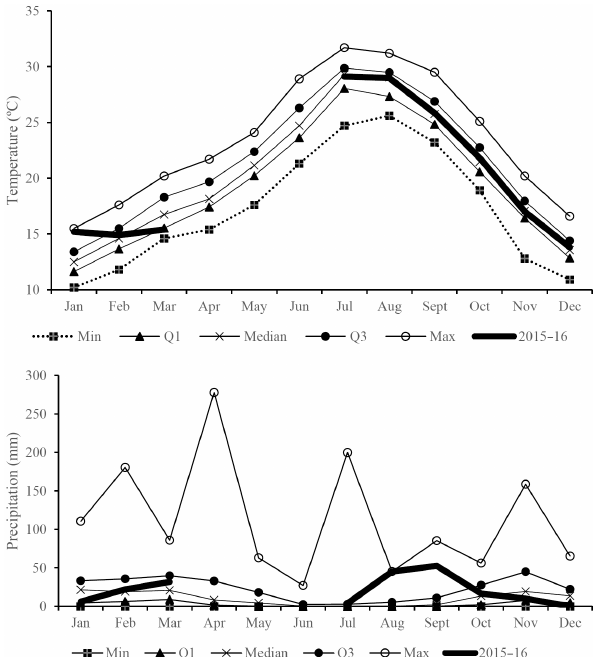
Figure 4. Statistics of mean annual monthly air temperature and precipitation at Menara (Marrakesh) from 1977 to 2015 and during the study period (July 2015–March 2016; thick black line). Data source: